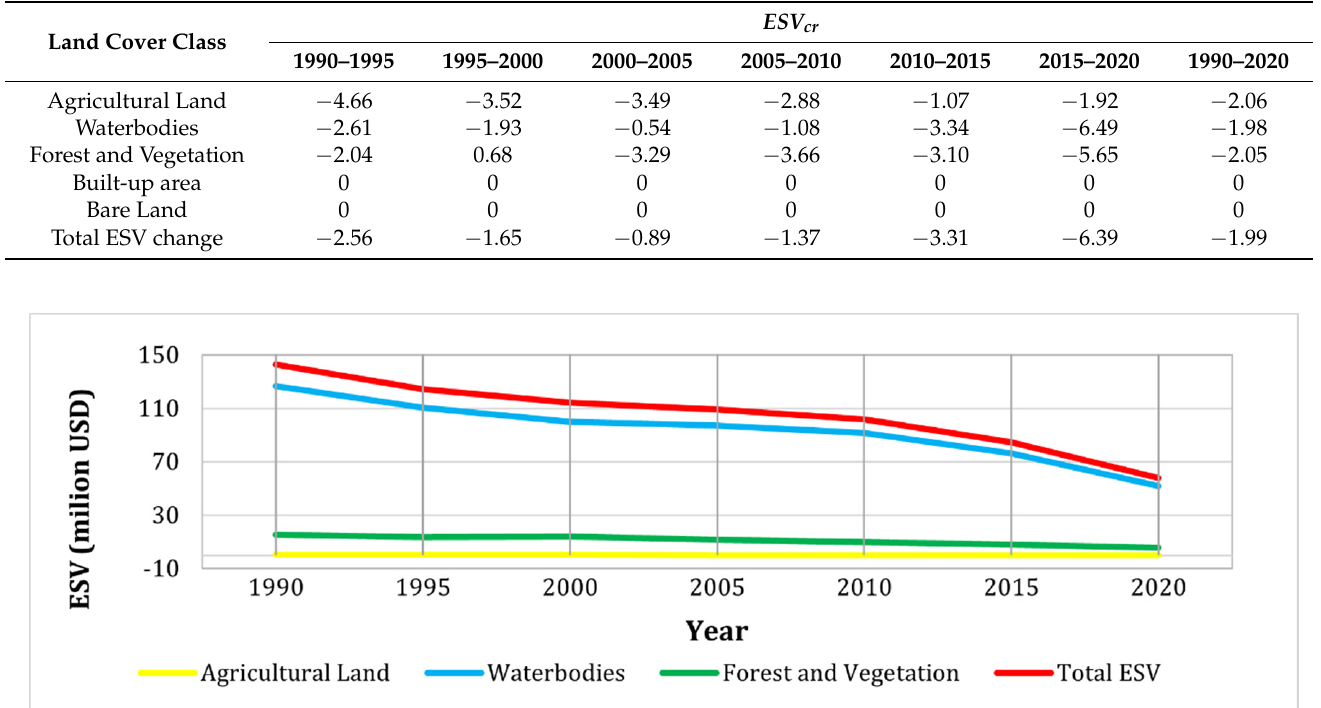
Figure 4. Trend of total ESV in Dhaka during 1990–2020.